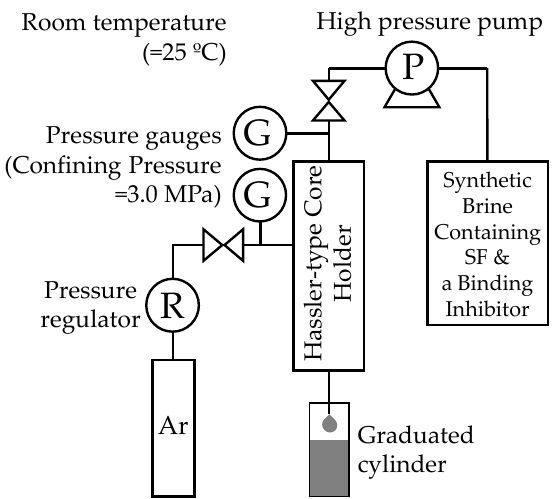
Figure 1. Schematic image of the permeability measurement system used in this study.